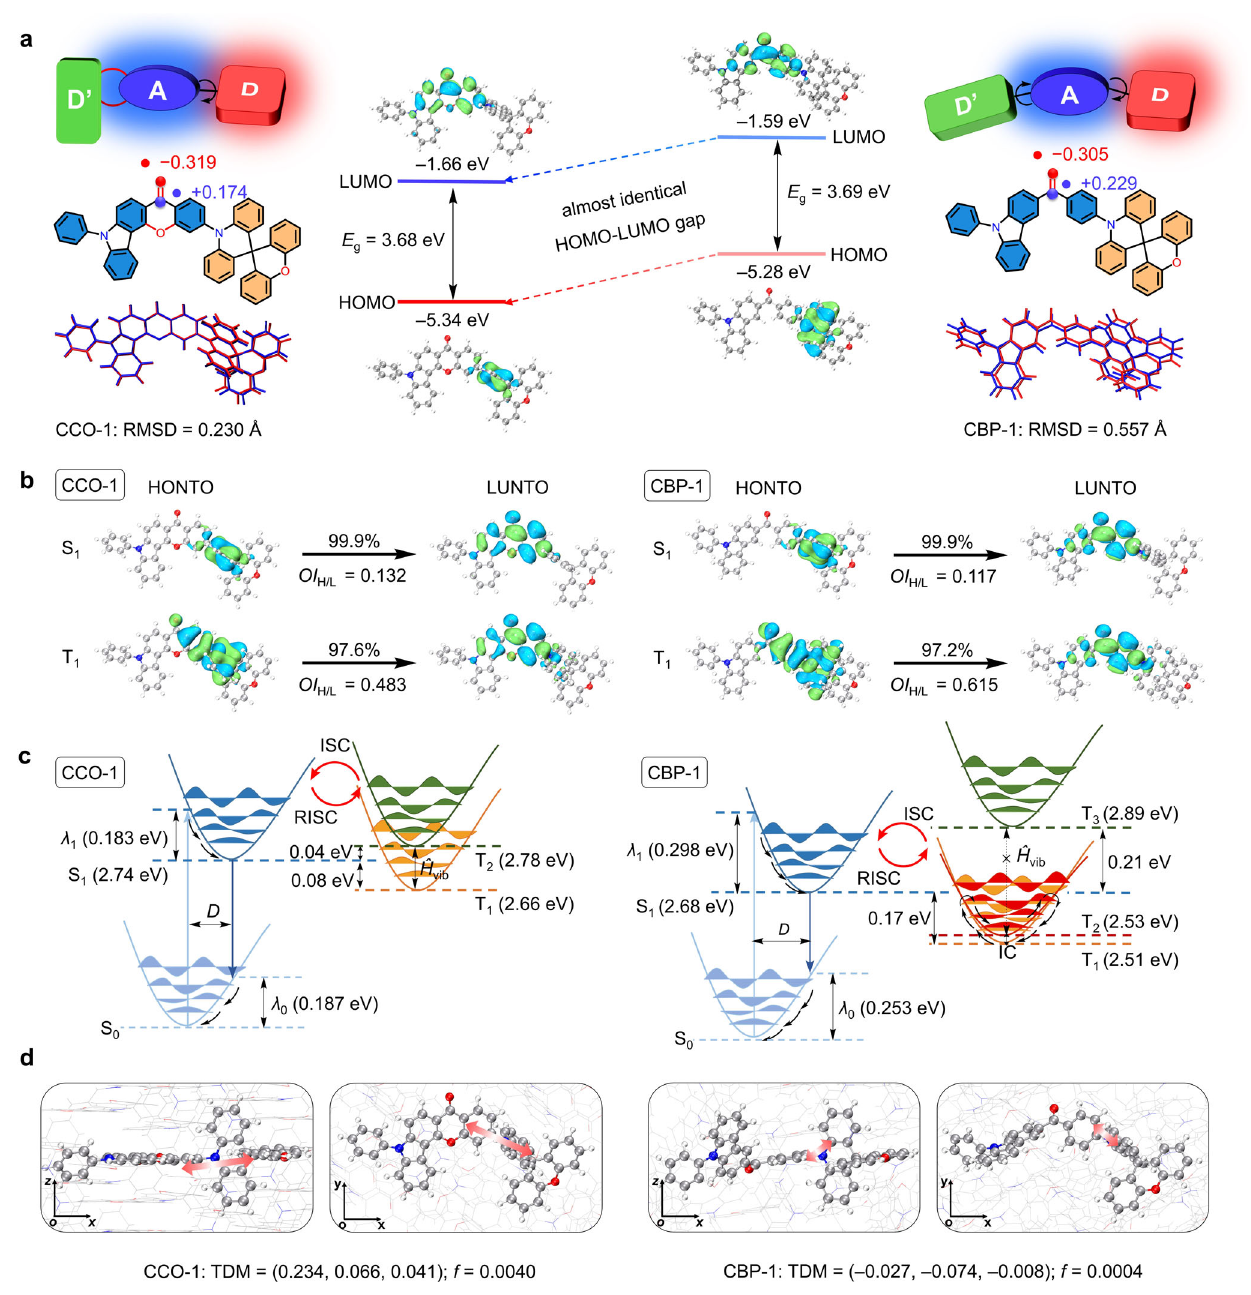
Fig.2|AnalysesofquantumchemicalcalculationsresultsforCCO-1andCBP-1. a Calculated orbital distributions and energy levels of HOMO and LUMO, atomic dipole moment corrected Hirshfeld charge populations of carbonyl, and the root mean squared displacement (RMSD) between optimized S 0 (red) and S 1 (blue) geometries. b NTO distribution and overlap integral of norm of HONTO and LUNTO ( OI H/L ) of S 1 and T 1 states for CCO-1 and CBP-1, respectively. c Energy level